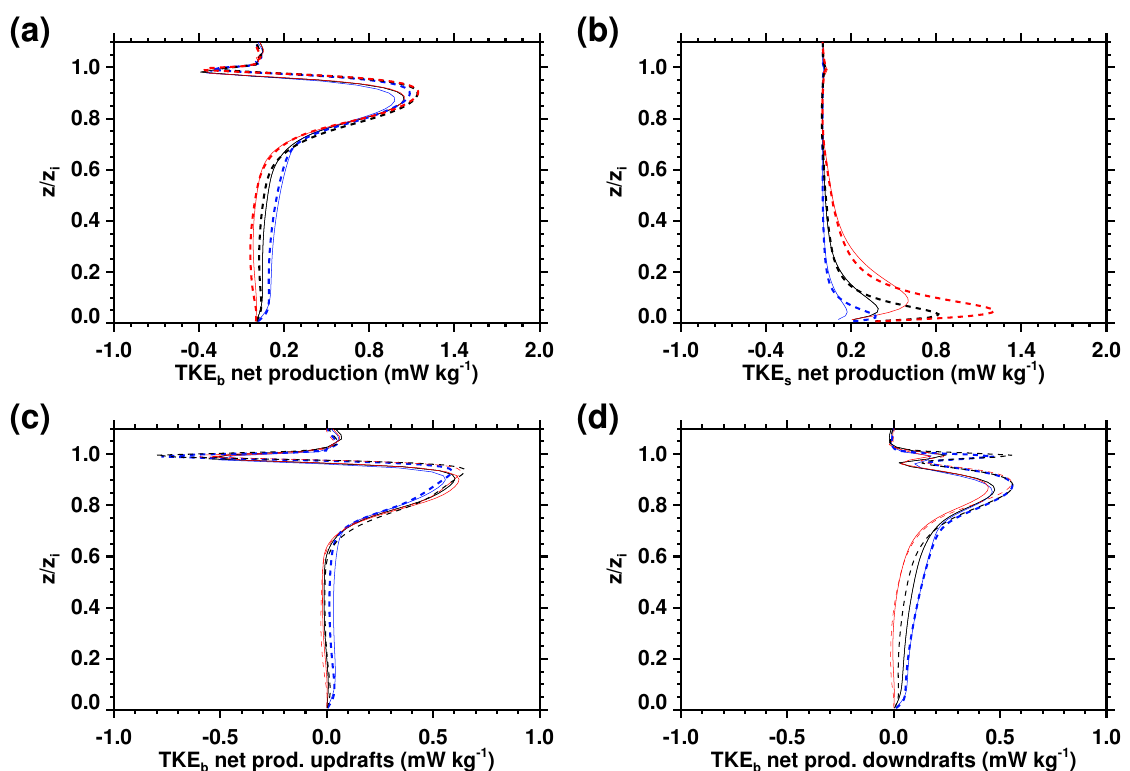
Figure C10. Effect of resolution. Profiles averaged over 1h in the period C (22:30–23:30UT) from simulations M − (blue), M 0 (black), M + (red), solid curves, and from simulations M − (blue), M 0 (black), M + (red), dashed curves. TKE b denotes buoyant production, TKE s fine fine fine shear production of turbulence kinetic energy. TKE b and TKE s in updrafts and downdrafts are air mass weighted sums over the updraft or downdraft locations at each level, respectively, normalized by the level air